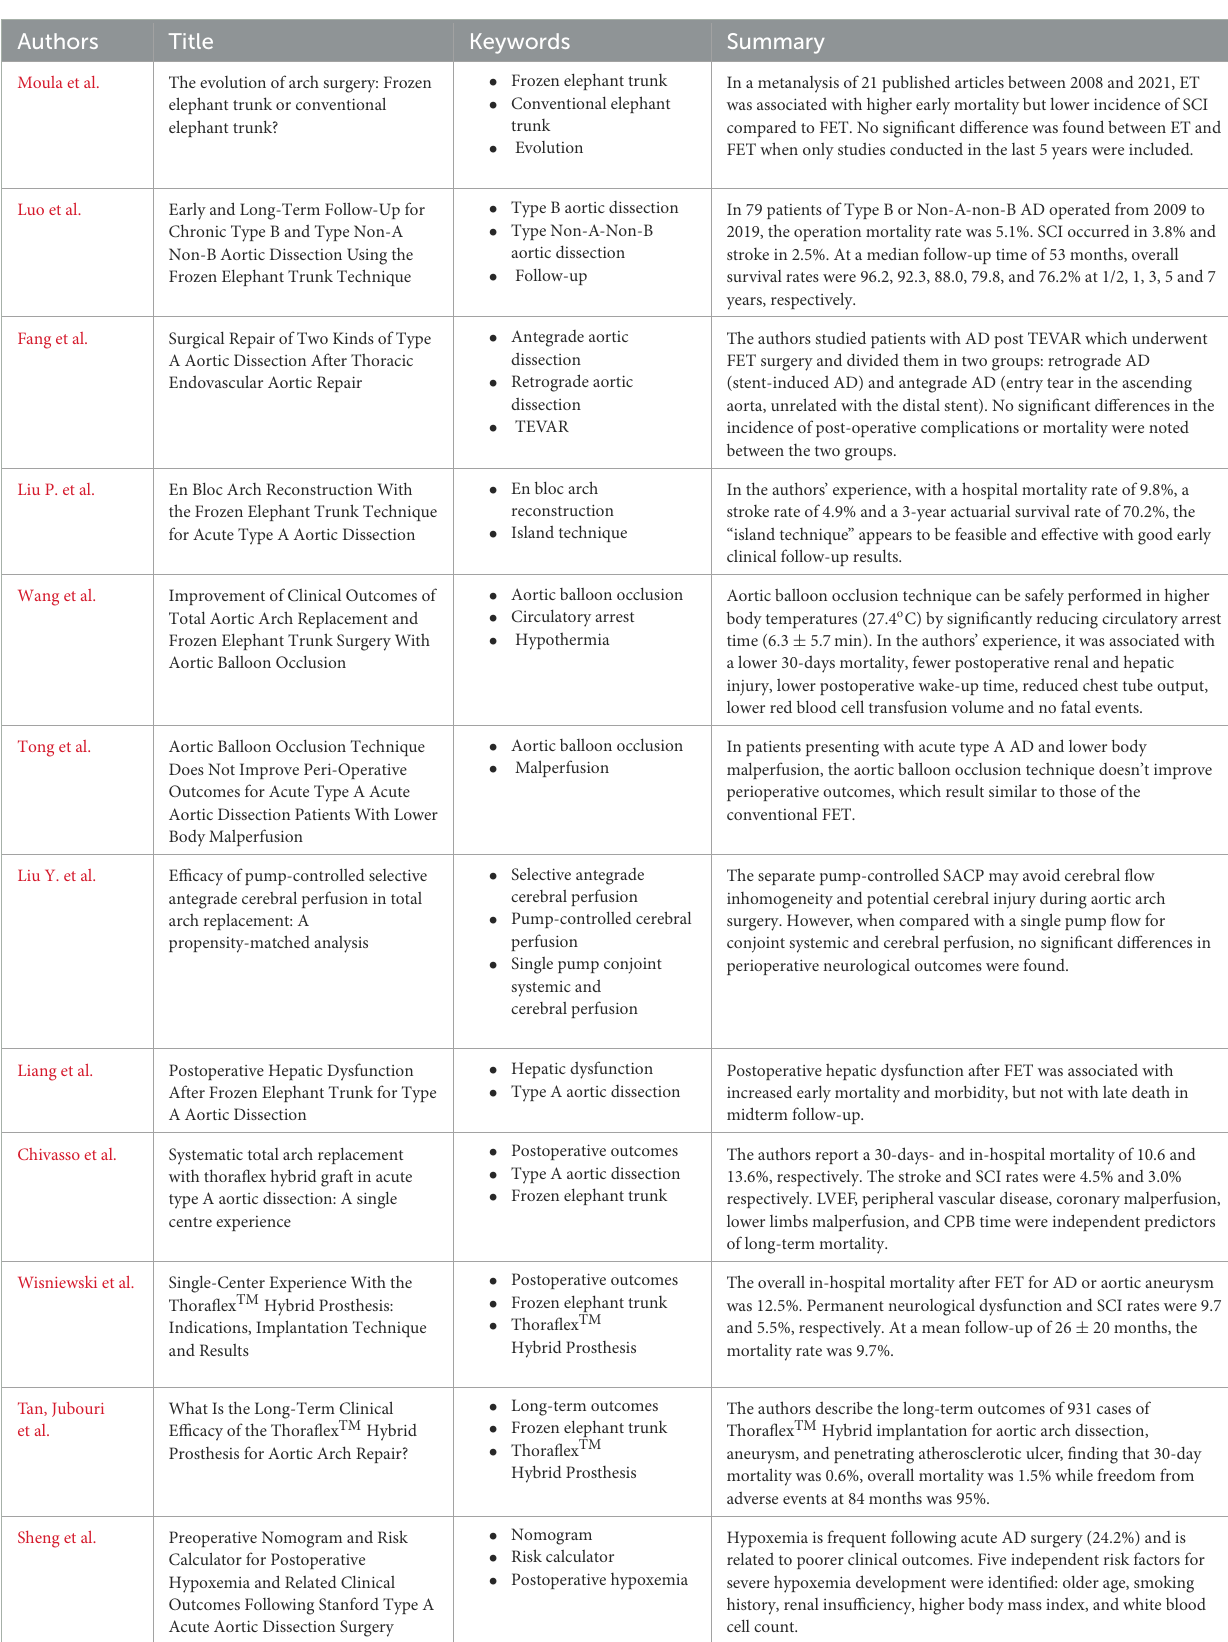
TABLE 1 Summary of the collection of the